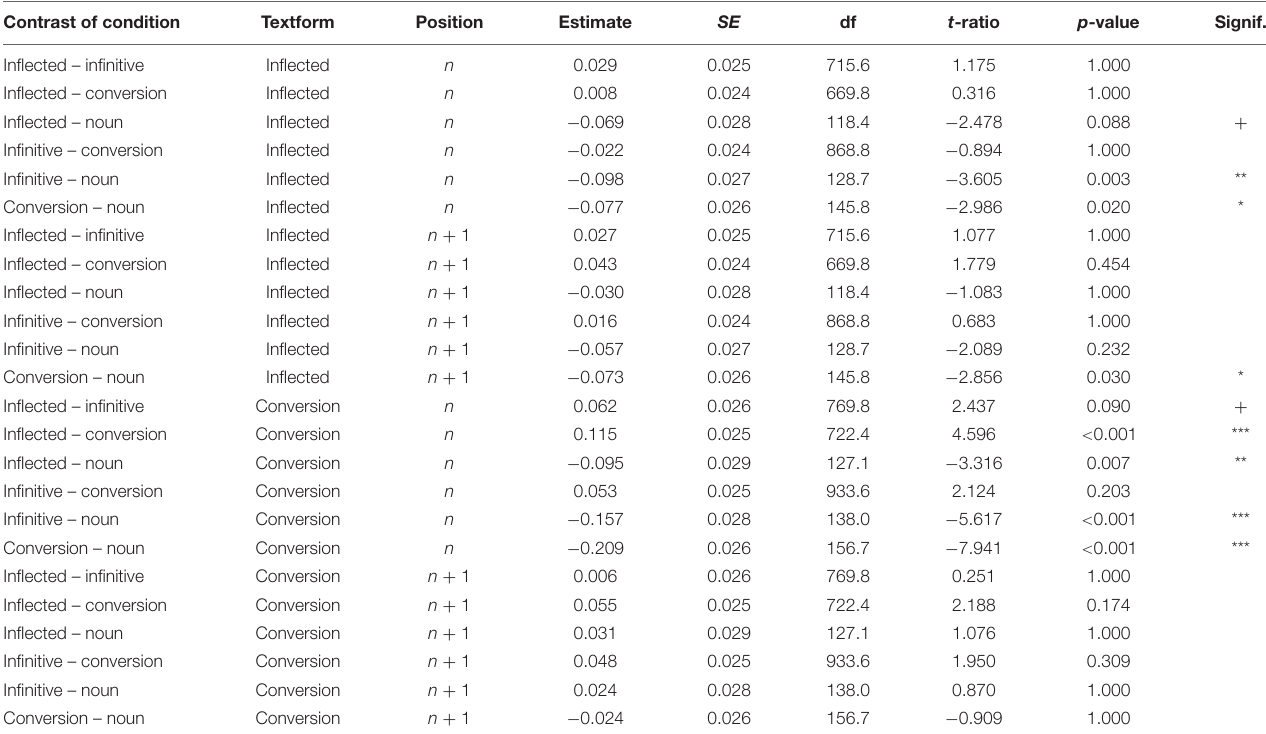
TABLE 8 | Pairwise contrasts of estimated marginal means for the predictor ‘Condition’ (by Position and TextForm) for Experiments L2A and L2B (non-native participants). Contrast of